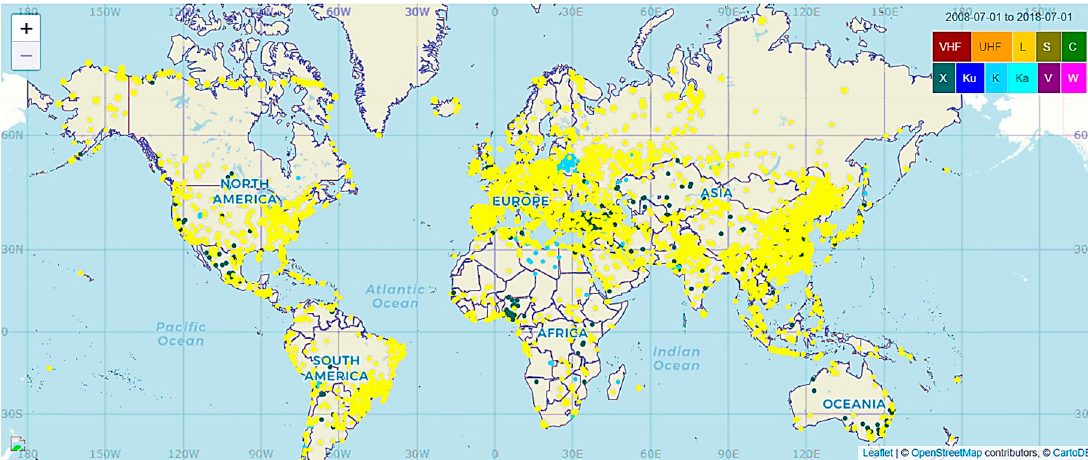
Figure 1. Distribution of observed radio frequency interference (RFI) sources from different frequency bands spread over the global area. The circles with different colors corresponding to the RFI sources observed in various frequency bands, as shown in the legend at the upper right corner. Captured from the database of frequency allocations for microwave remote sensing and observed radio frequency interference [ Error! Reference source not found. ].